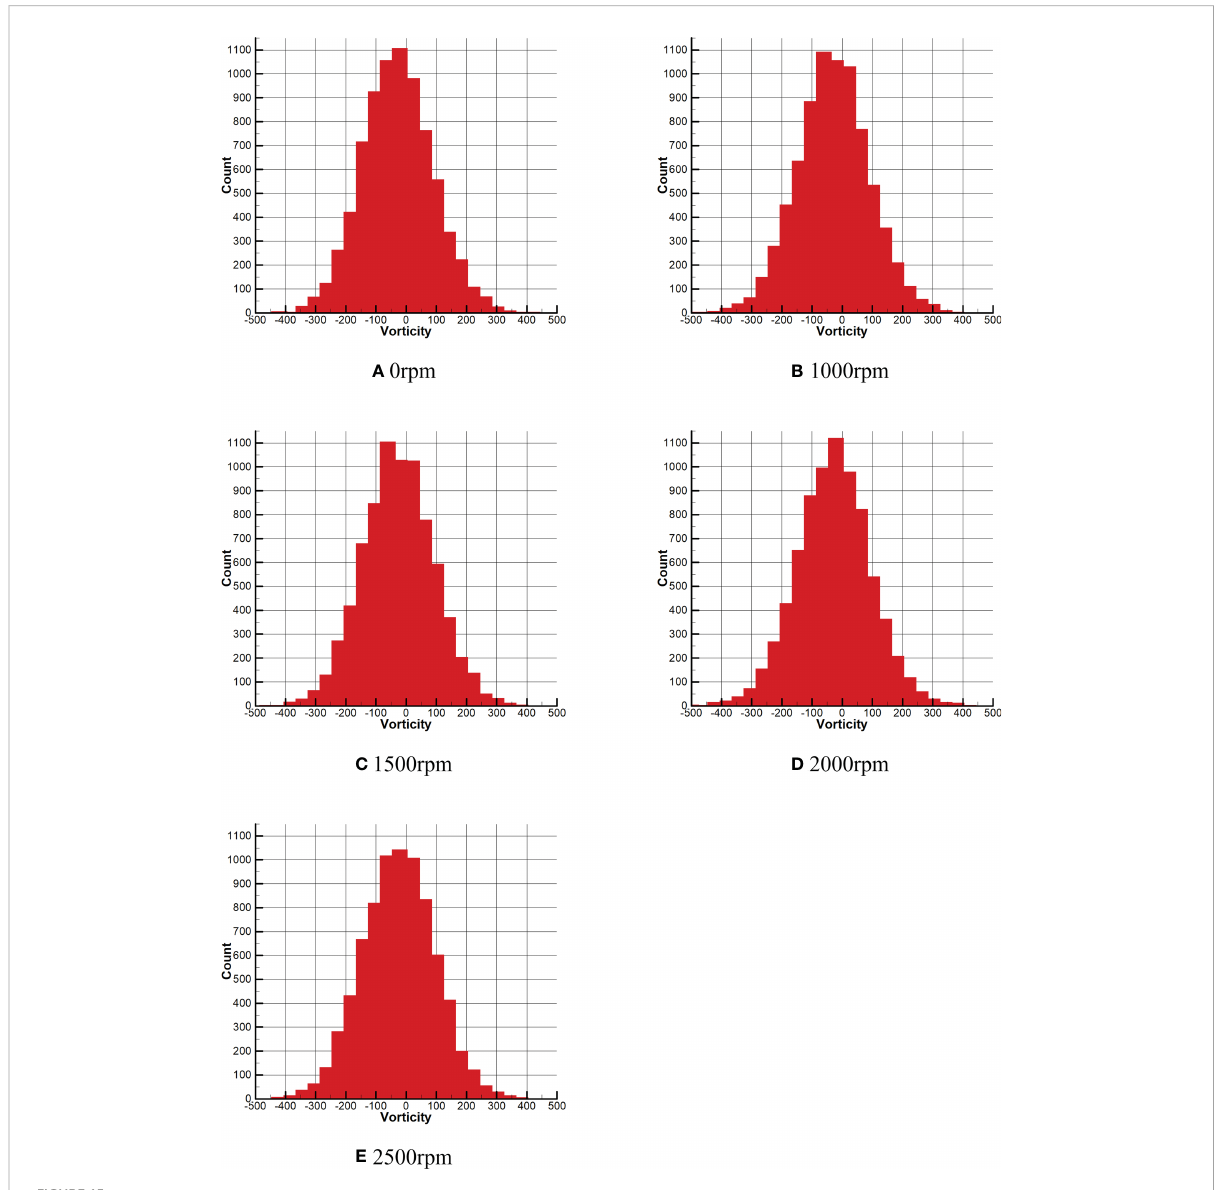
FIGURE 15 Quantity distribution of the average droplet vorticity at different rotor